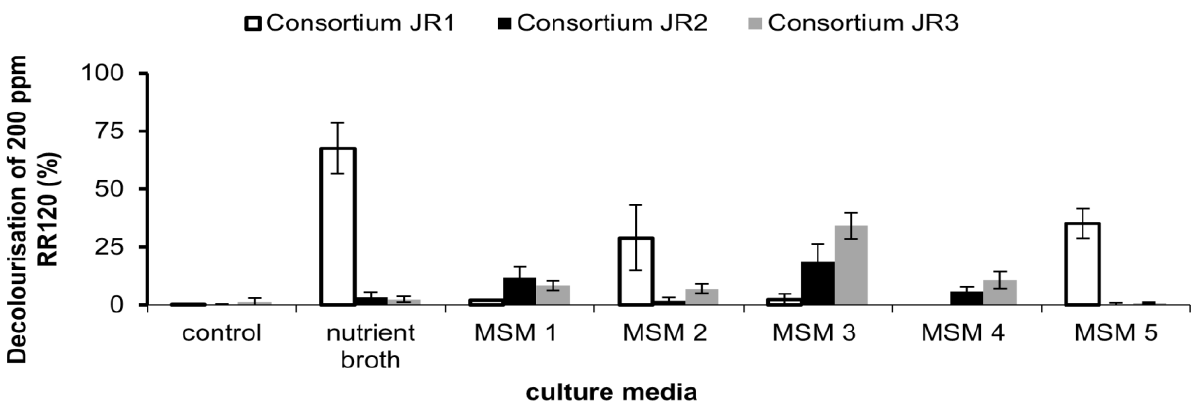
Figure 6. Effect of different media composition on decolourisation of 50 ppm Reactive Red 120 by consortium JR1, JR2 and JR3. Data represent mean ± SD, n = 3.